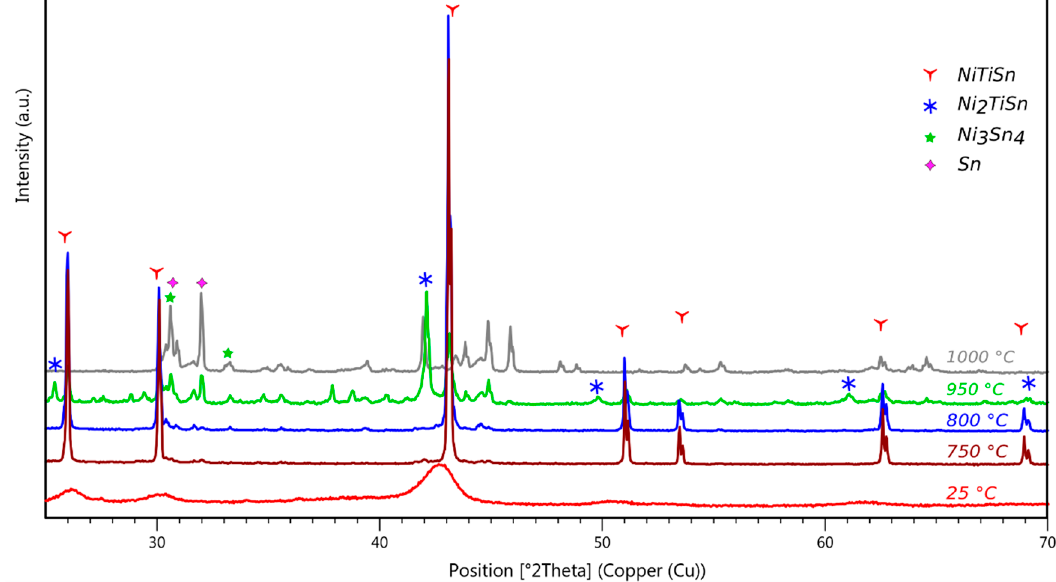
Figure 8. XRD patterns for samples prepared by MA at 600 rpm for 5 h and annealed for 10 days at temperatures from 750 to 1000 °C (25 °C corresponds to the non-annealed sample).